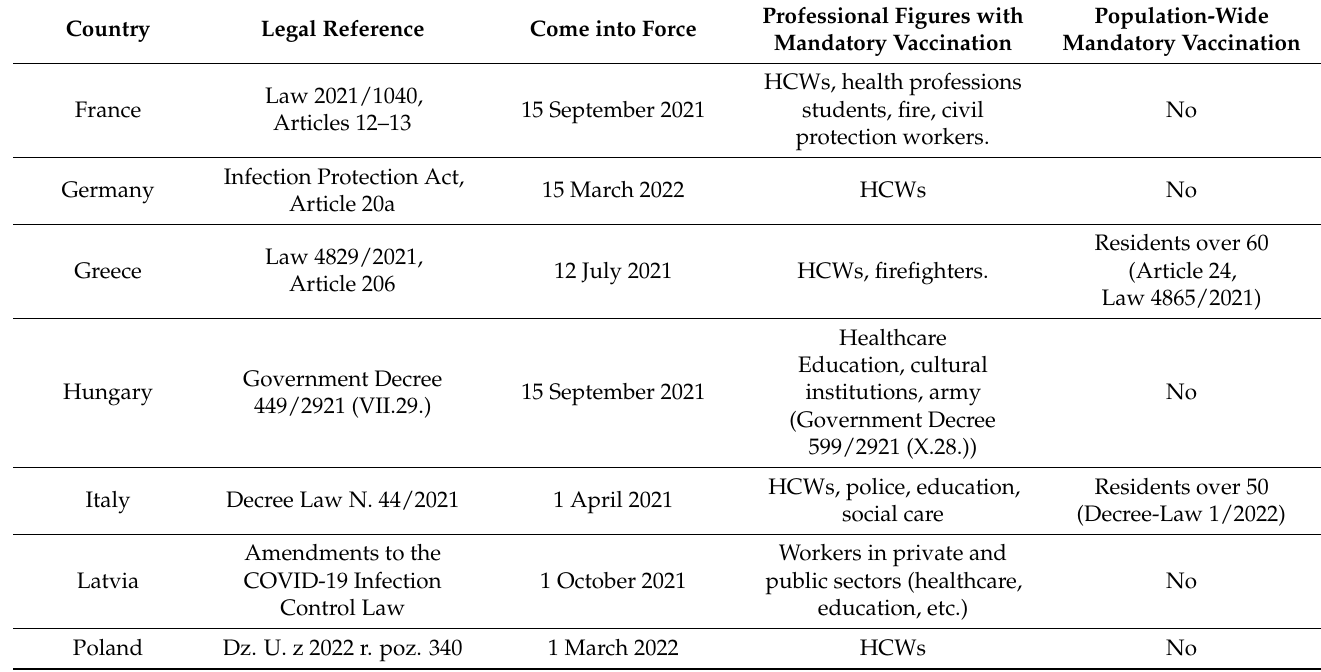
Table 5. European countries with mandatory COVID-19 vaccination for healthcare